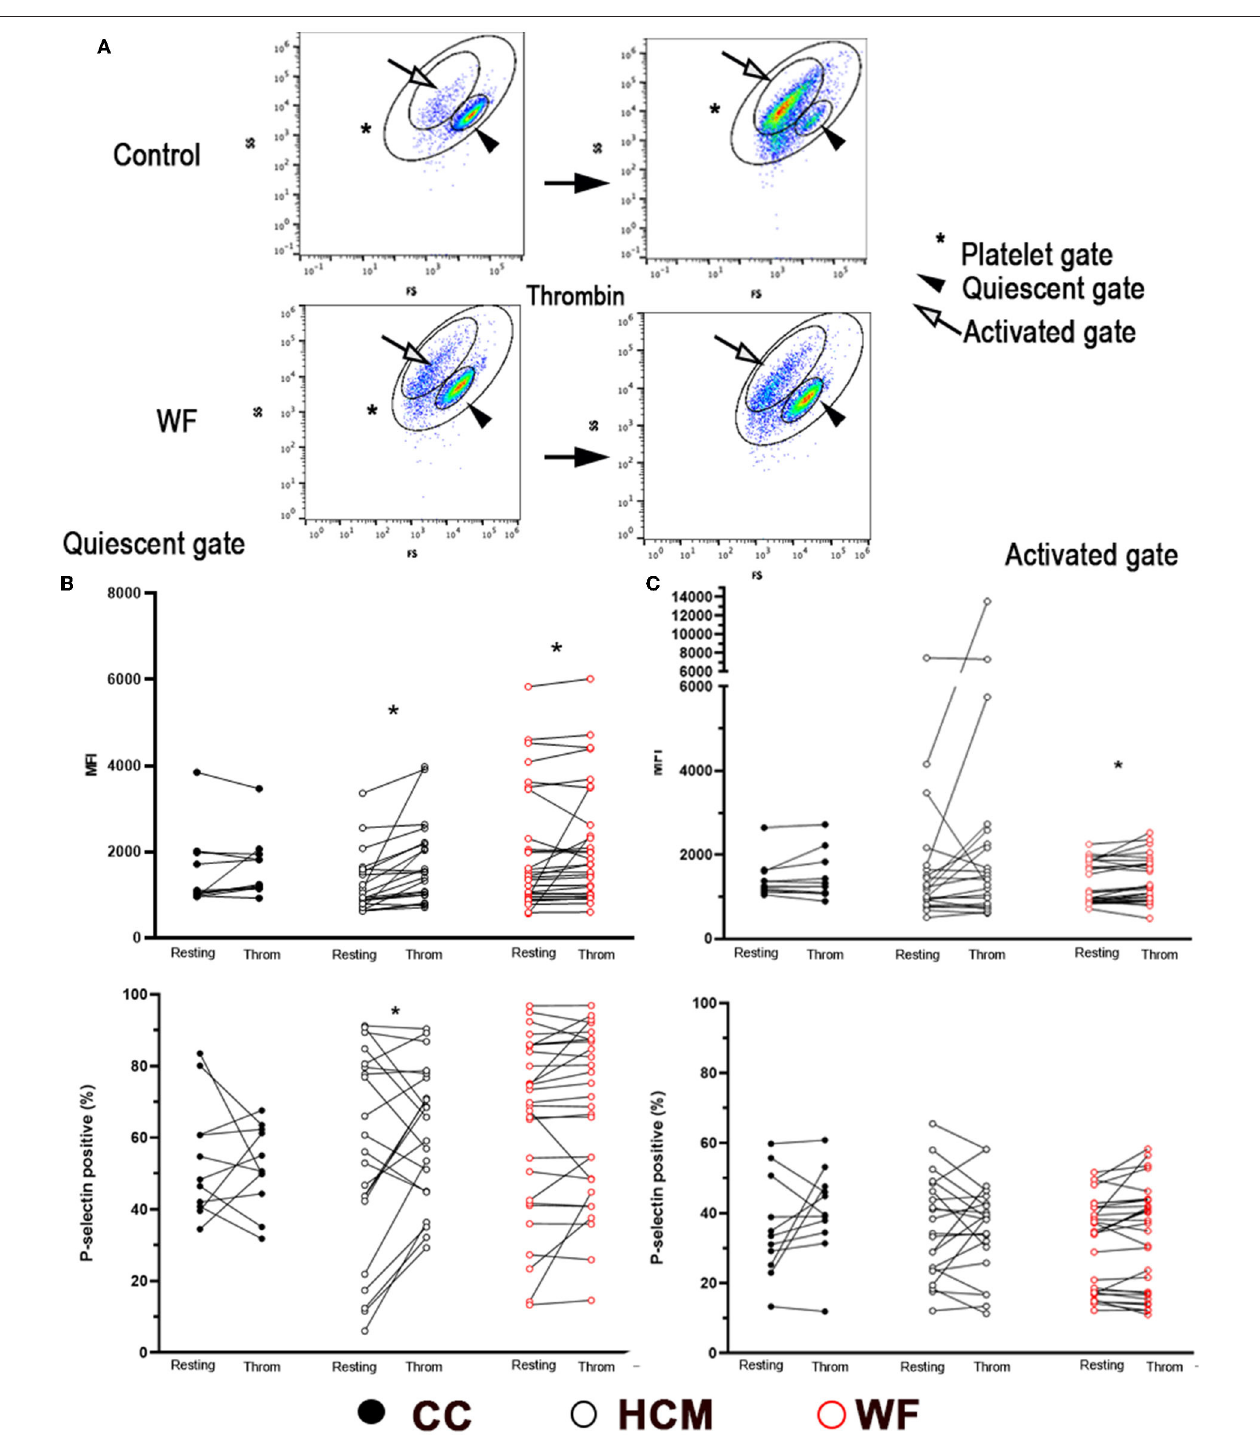
FIGURE 3 | Representative scatter dot plot diagrams, gating strategy and P-selectin expression in thrombin-activated platelets. (A) Platelets were first identified by forward (FS) and side scatter (SS) properties (*Platelet gate). With thrombin activation (0.01 U/ml), events were further gated based on scatter properties to either Quiescent (arrowhead) or Activated (arrow). Note the shift of cells from the Quiescent to Activated gates following thrombin treatment in a control cat while the number of events was similar in either gate in a cat exposed to wildfires. Platelet activation, measured as percentage of P-selectin positive events, or median fluorescence intensity (MFI) was compared before and after thrombin stimulation in 29 cats exposed to wildfires (WF), 21 cats with subclinical hypertrophic cardiomyopathy (HCM) and 11 control cats without HCM (CC). (B) In the Quiescent gate, thrombin resulted in elevated P-selectin in HCM and WF groups but no difference was noted among the three groups. (C) Only cats in the WF group had elevated levels of P-selectin (MFI) in the Activated gate following thrombin stimulation. * p > 0.05.